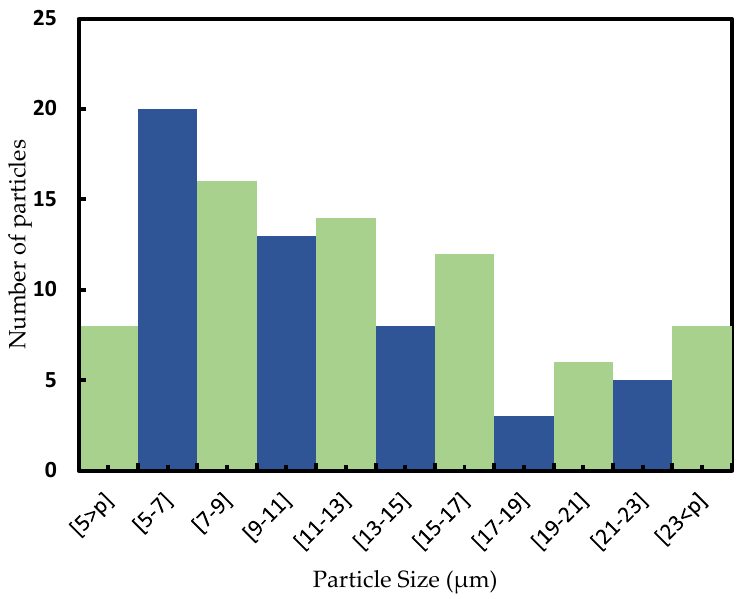
Figure 6. Number of particles vs particle size histogram showing the distribution of Cu powder. The numbers in brackets on the x-axis denotes the size range in microns. The particle size distribution was based on the image evaluation of 113 particles.